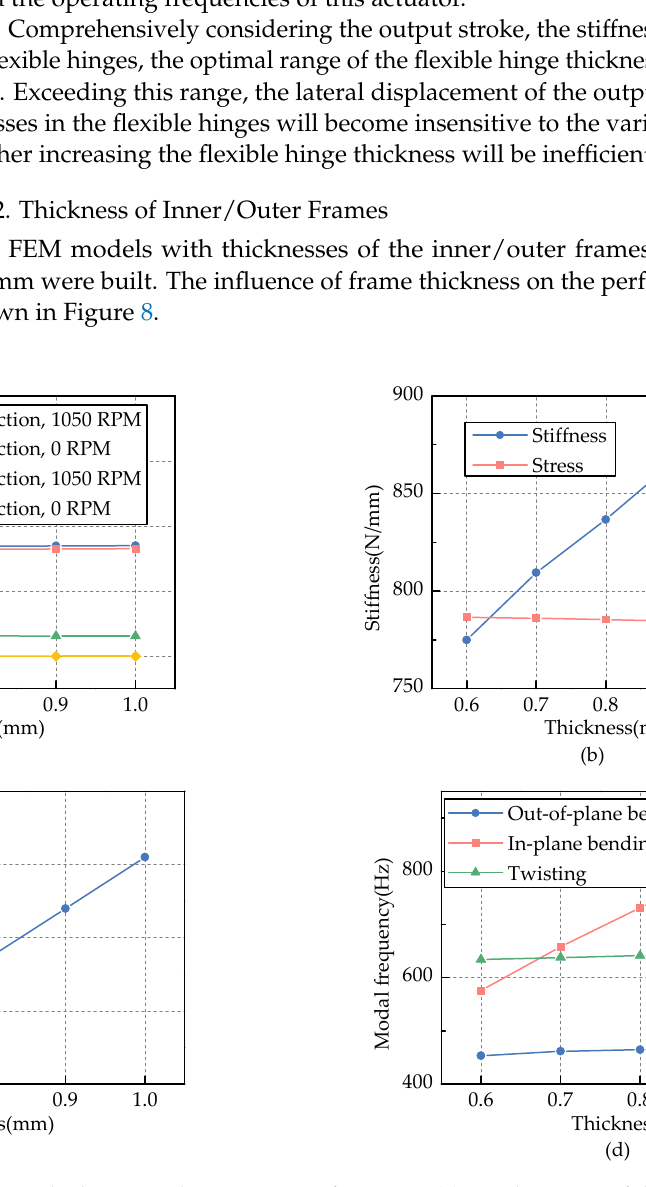
Figure 8. The influence of the frame thickness on the actuator performance: ( a ) Displacement of the actuator; ( b ) Stiffness and structural stress of the actuator; ( c ) Mass of the frames; ( d ) Modal frequencies of the actuator.